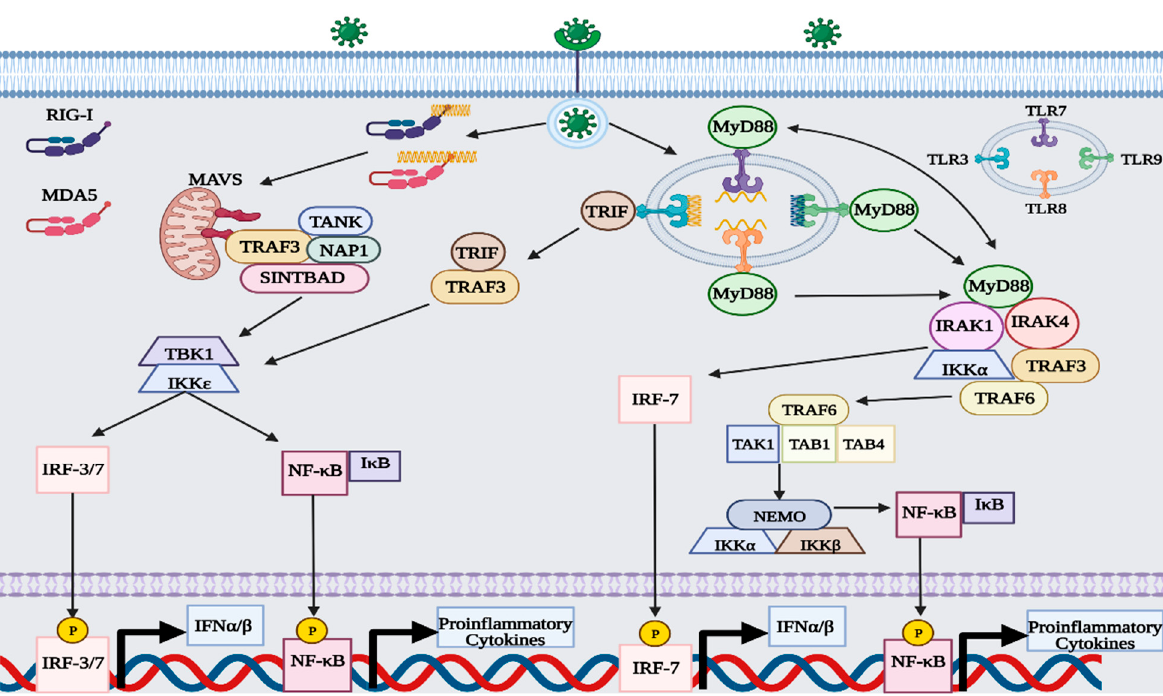
Figure 1. Overview of RLR and TLR pathway during viral infection. The recognition of viral nucleic acids by RLRs and TLRs induces activation of IRF-3/7 and NF- κ B by phosphorylation, thus upregulating the expression of type-I IFNs and proinflammatory cytokines, respectively. This figure was created with BioRender.com (accessed on 20 January